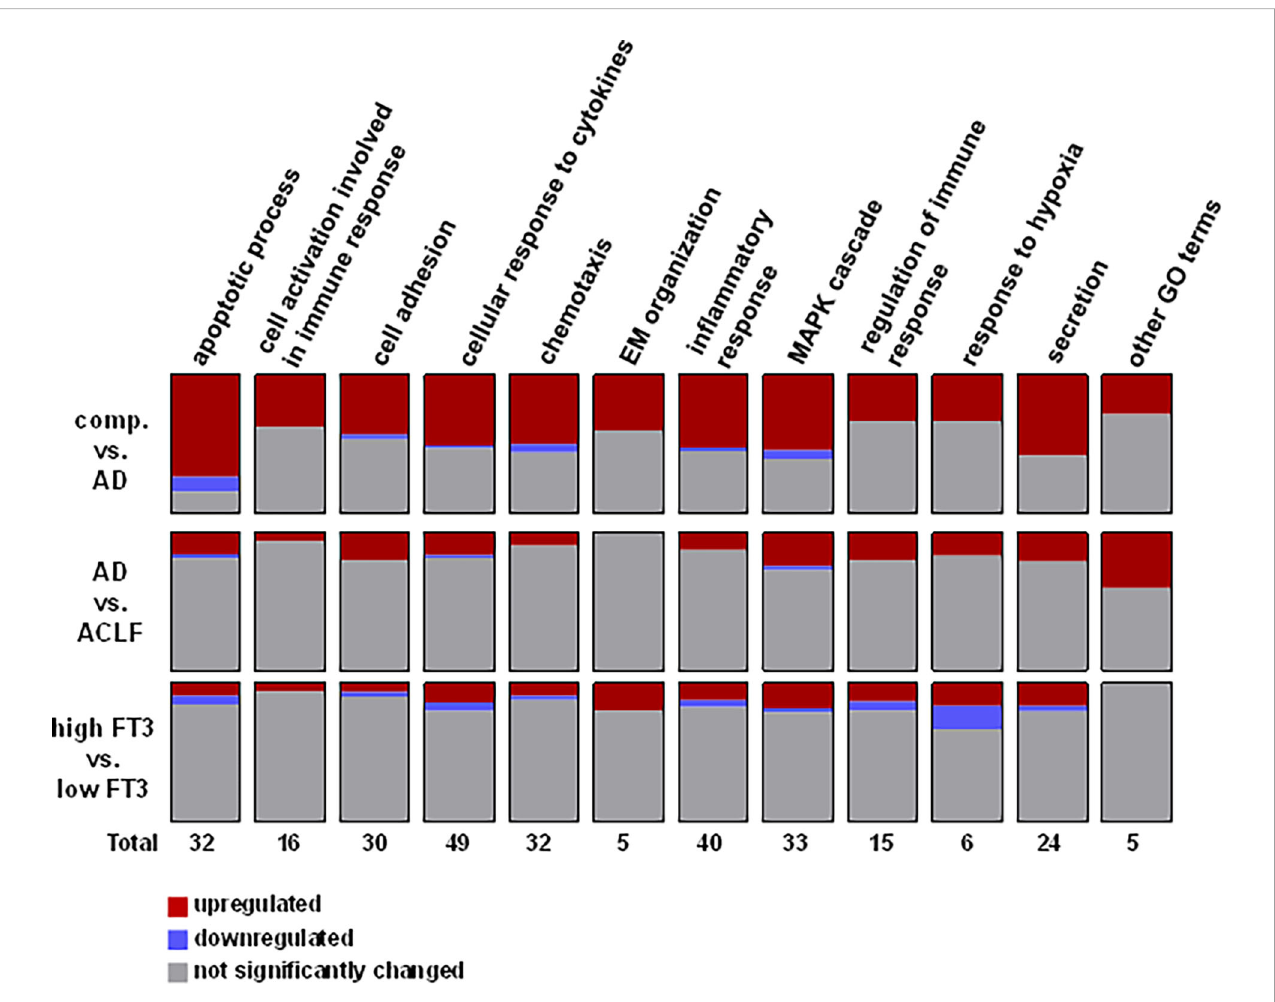
FIGURE 5 Pathway analysis of proteins detected by proximity extension analysis